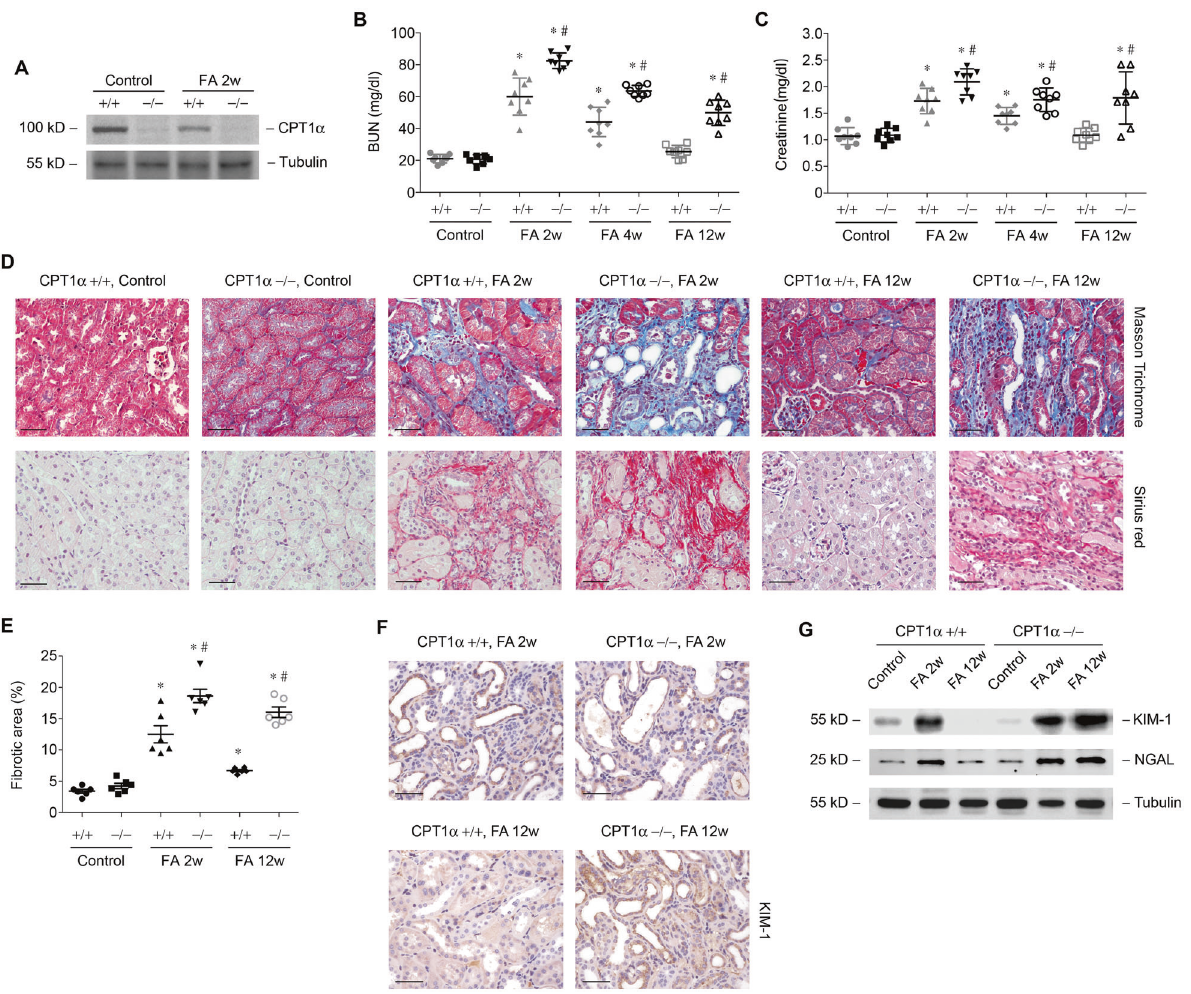
Fig. 3 Genetic ablation of CPT1 α aggravates tubular cell injury and hampers kidney repair. A Western blot analysis of protein expression of CPT1 α in kidney samples from groups as indicated. Changes of BUN ( B ) and creatinine ( C ) in groups as indicated. n = 8 for each group. D Representative images of mice kidney samples from groups as indicated stained with Masson trichrome and Sirius red. E Percentage of the fi brotic area in groups as indicated. n = 6 for each group. * P < 0.05 versus control. # P < 0.05 versus CPT1 α + / + . F Representative images of mice kidney samples immunostained with KIM-1. G Western blot analysis of protein expression of KIM-1 and NGAL in kidney samples from groups as indicated. Scale bar, 50 μ